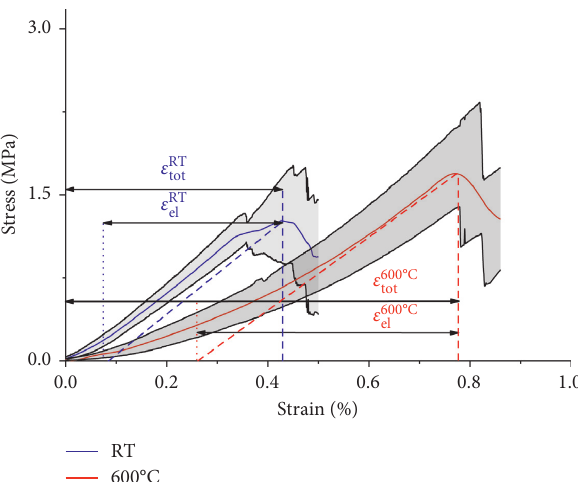
Figure 17: Brazil splitting stress-strain diagram (the loading curve in the figure is the result of fitting multiple Brazilian splitting curves, and the shaded part represents the error band of one standard deviation).